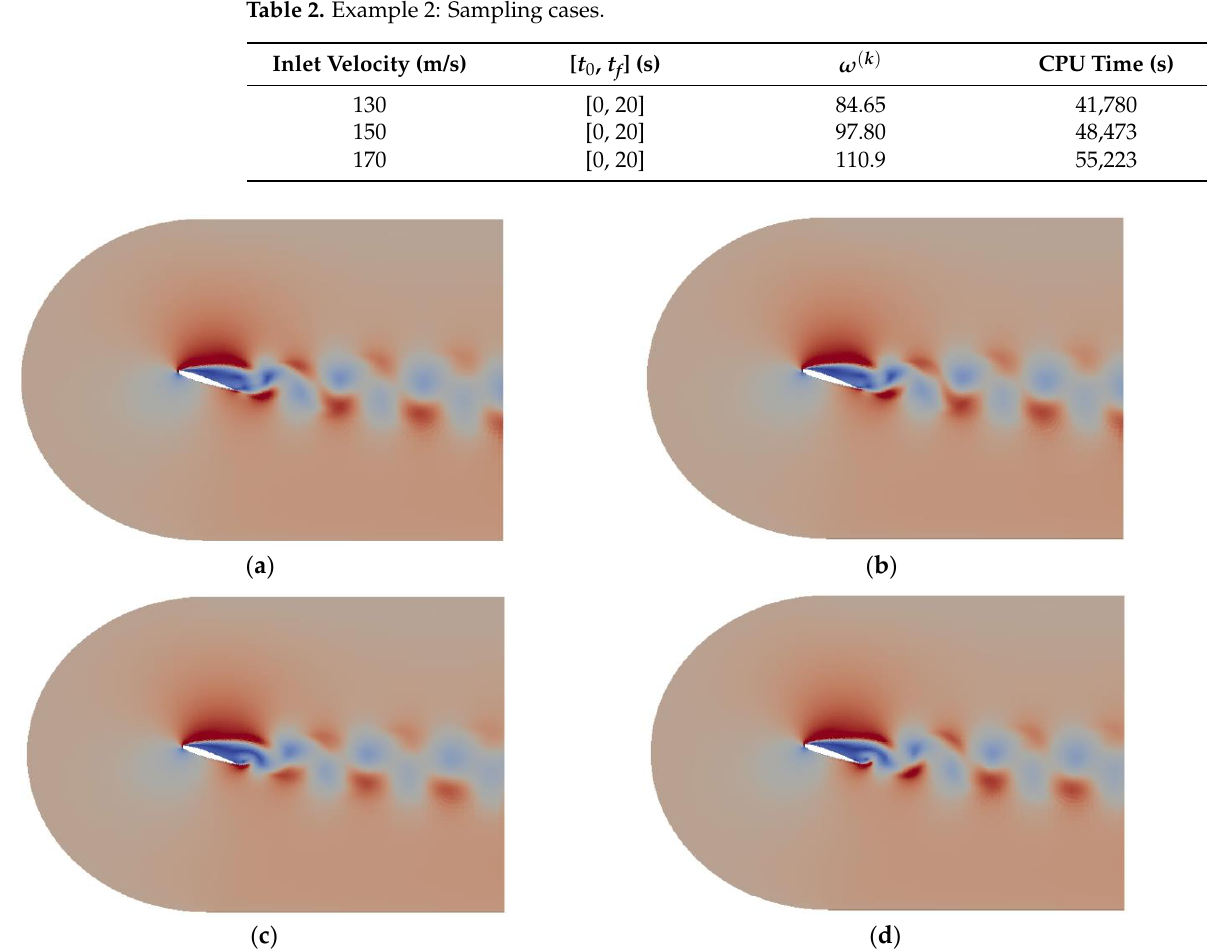
Figure 9. Example 2: Comparison of velocity distributions of the proposed ROM and OpenFOAM with an inlet velocity of 140 m/s: ( a ) ROM at t = 1.5248 s; ( b ) OpenFOAM at t = 1.5248 s; ( c ) ROM at t = 17.1062s; ( d ) OpenFOAM at t = 17.1062s. Table 2. Example 2: Sampling cases.